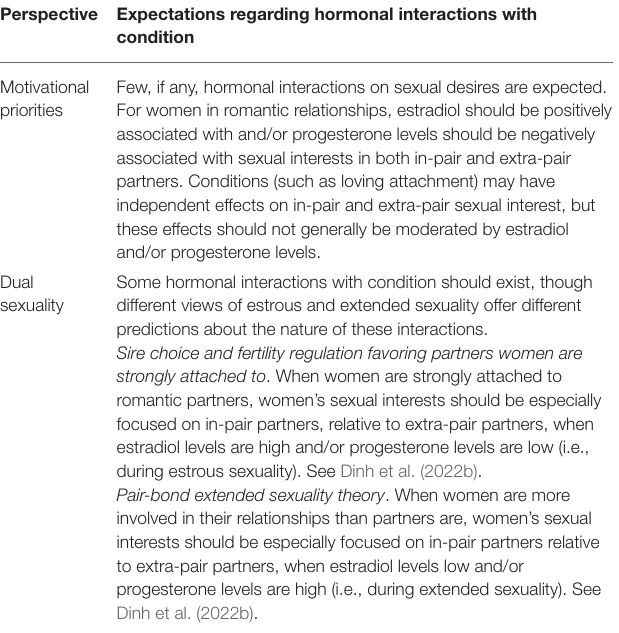
TABLE 1 | Illustrative effects that distinguish the motivational priorities perspective and the dual sexuality framework. Perspective Expectations regarding hormonal interactions with condition Motivational